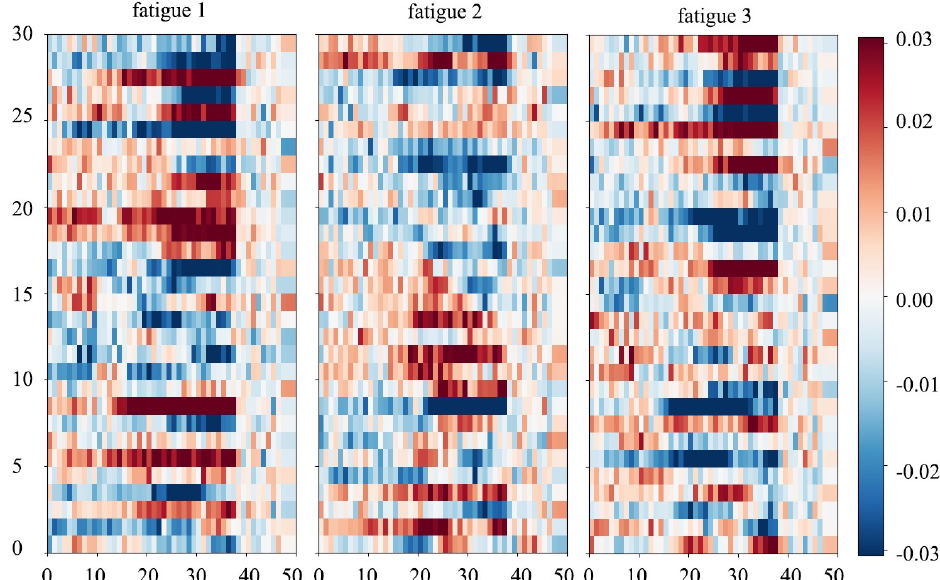
Figure 4. Correlation value between input perturbation and dense output for different fatigue levels at various electrodes (y-axis) and frequency (x-axis). According to the color bar (right), deep red or blue indicate a stronger correlation between input and output. We can observe clearly that most high correlation values are located at the partial-occipital area (channel number from 20 to 30) with the frequency band of 15–40 Hz. This suggests that in our net the high-frequency activities in the partial-occipital area are more likely to be used in